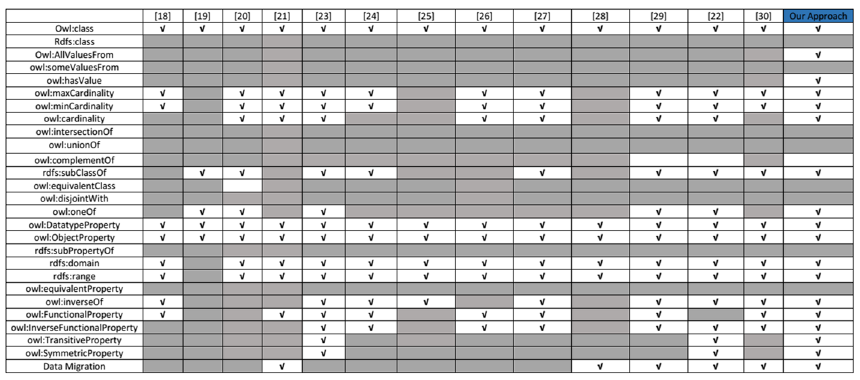
Table 10 Ontological output of each mapping approach